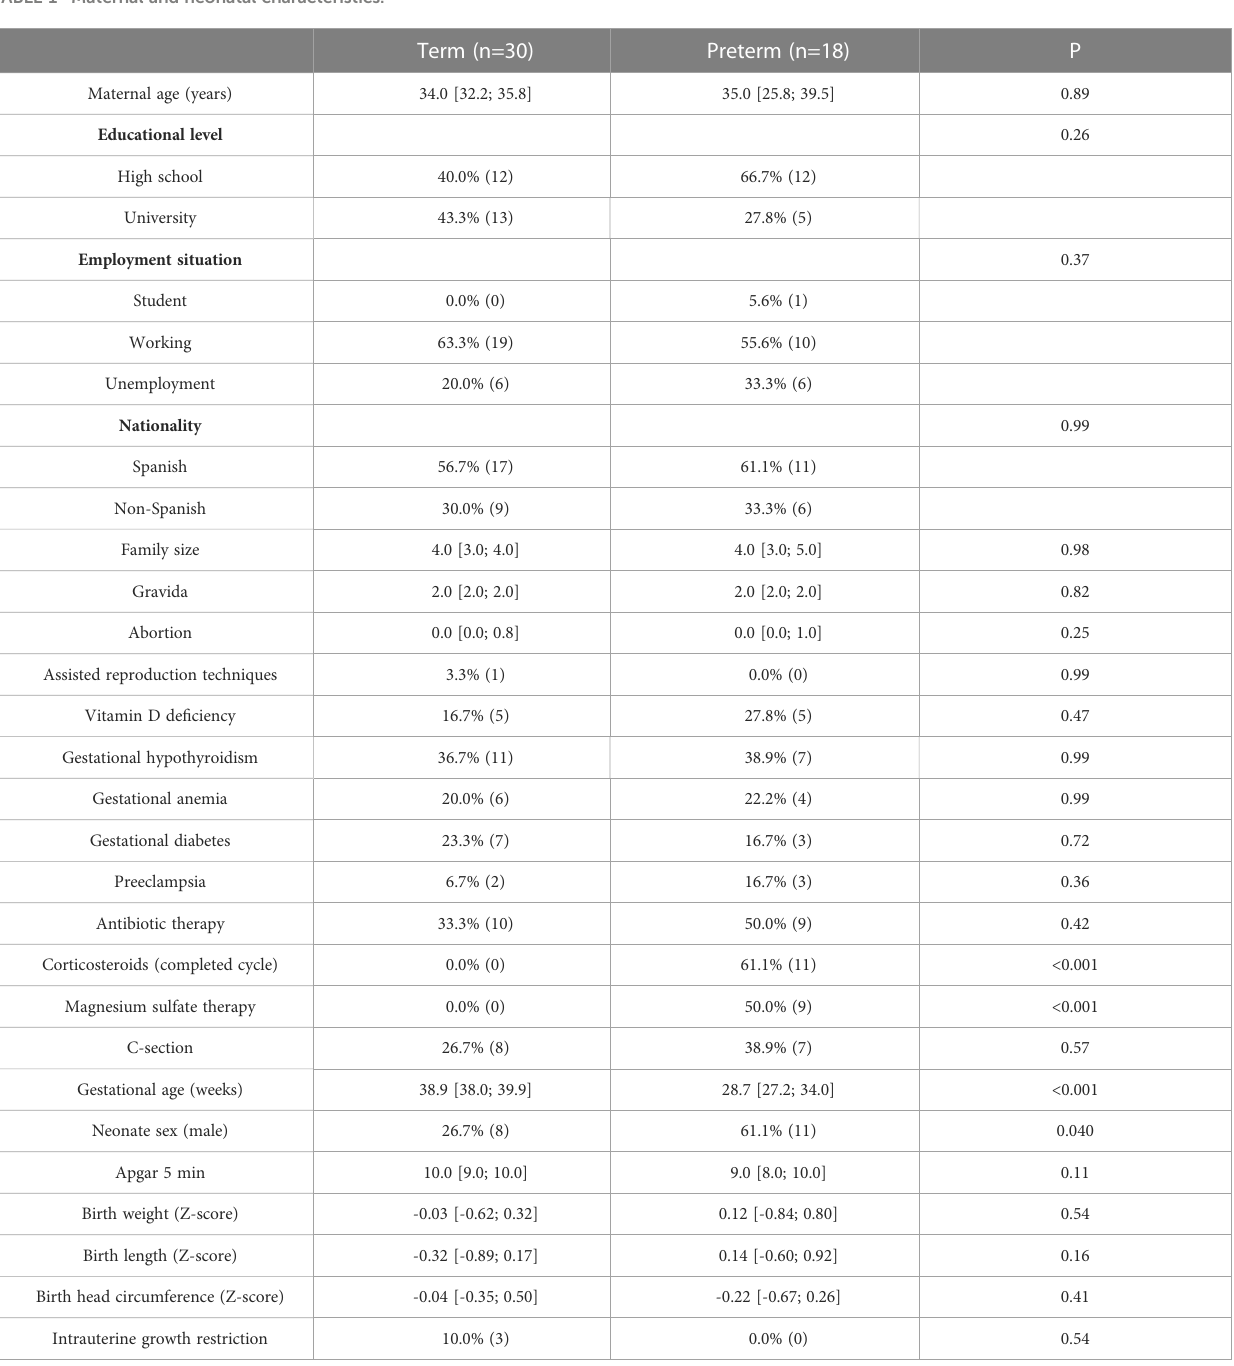
TABLE 1 Maternal and neonatal